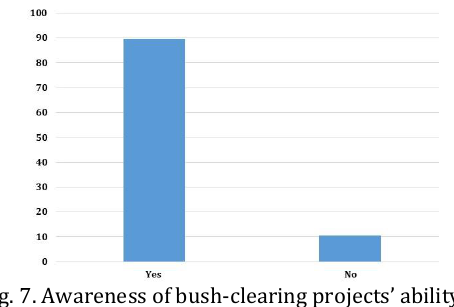
Fig. 7. Awareness of bush-clearing projects’ ability to improve livelihood (Source: own elaboration)